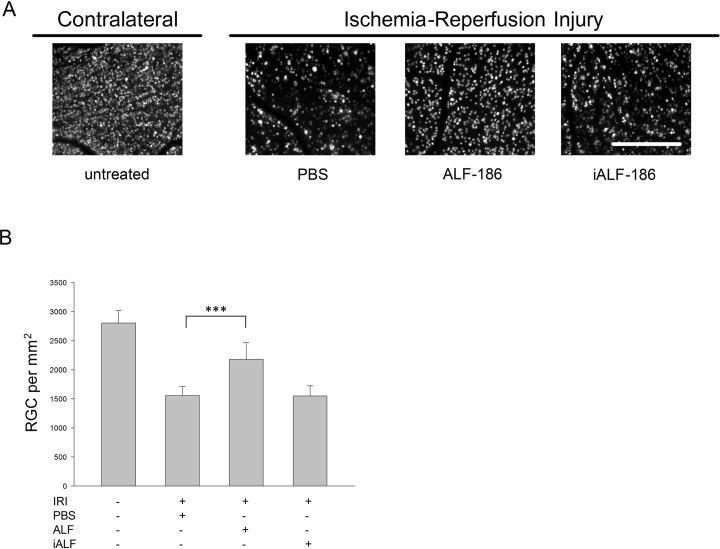
Protection of retinal ganglion cells (RGC) by intravitreal-administered ALF-186 after ischemia-reperfusion-injury (IRI).(A) Representative images of flat mounted retinae seven days after IRI to the left eye (left picture: untreated right eye without any treatment, picture 2–4: IRI eye after intravitreal injection of PBS, ALF-186, or iALF-186). RGC had been retrogradely labeled with fluorogold one week prior to intervention. A significant reduction of RGC-density was detectable after IRI and PBS or iALF treatment, while ALF protected RGC after IRI. Scale bar indicates 200 μm. (B) Quantification of RGC-density (cells/mm2; mean±SD; n = 6) revealed a marked protection of RGC after ischemia in the ALF-treated eyes in comparison to iALF or PBS. *** = p<0.001.